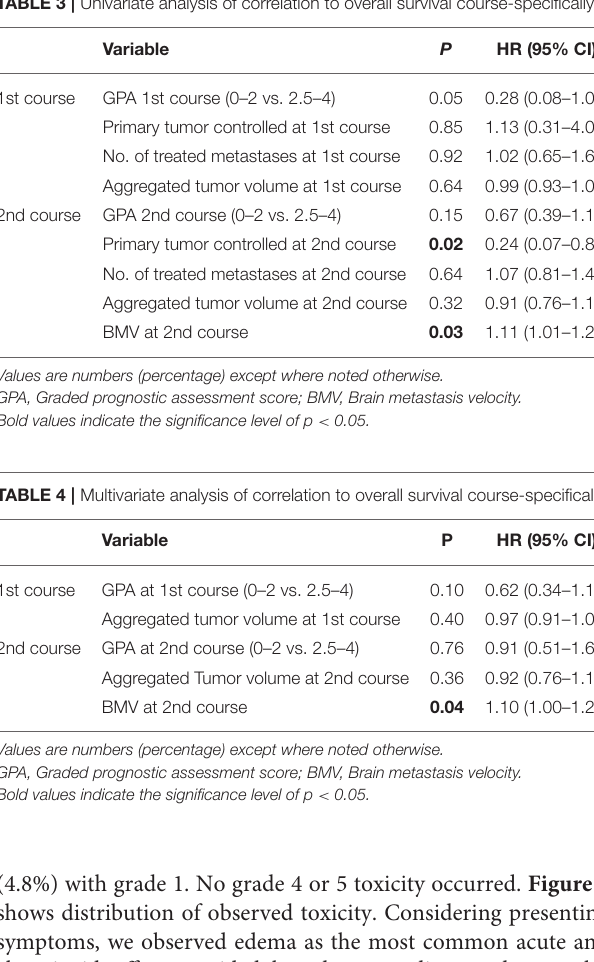
TABLE 3 | Univariate analysis of correlation to overall survival course-specifically.